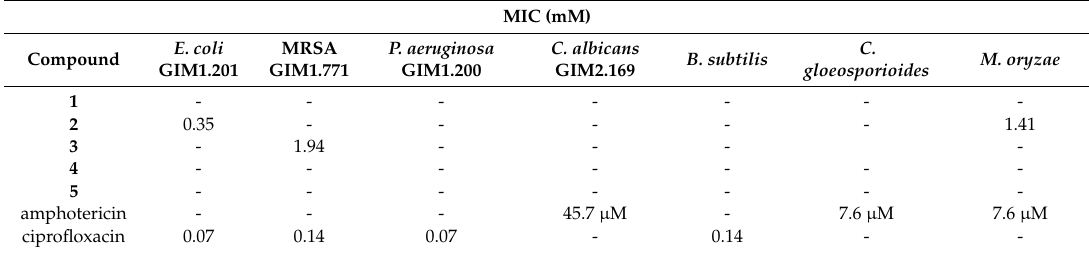
Table 1. Antimicrobial activities of compounds 1 – 5.